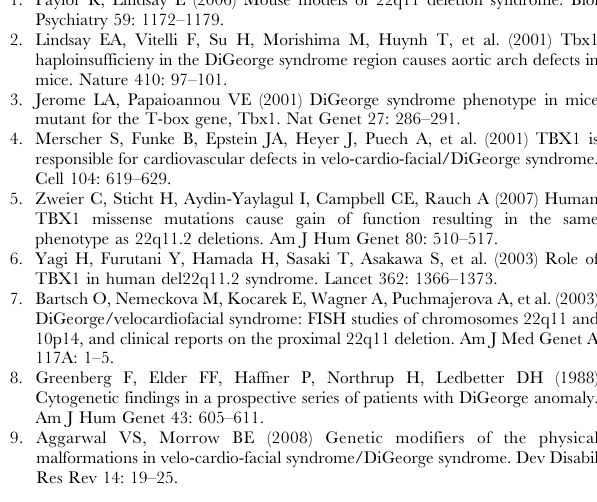
Figure S2 Outer ear morphologies in embryos of different Chrd genotypes. (A, B) Normal ears of Chrd + / + and Chrd + / 2 embryos at E18.5, respectively. (C–F) Ears of F2 Chrd hybrid mutants (129SB6F2- Chrd 2 / 2 ) displaying partially-defective outer ear mor- phologies. (G) Representative ear of inbred Chrd mutant embryo, showing the total failure of auricle formation. Figure S3 Status of Tbx1 locus in various relevant strains. A number of substrains of 129, the C57BL/6 strain and the parental R1 ES cell line used for targeting are devoid of Tbx1 G . T (represented by + / + genotype). The diagram shows the lineage relationship of many of these strains. Figure S4 Sequences of novel SSLP locus ChTb03 from B6 and 129S6 strains. Number of ‘CTT’ repetitions differs between the two strains, causing different lengths of amplified PCR product. Bold sequences are primers for PCR amplification.